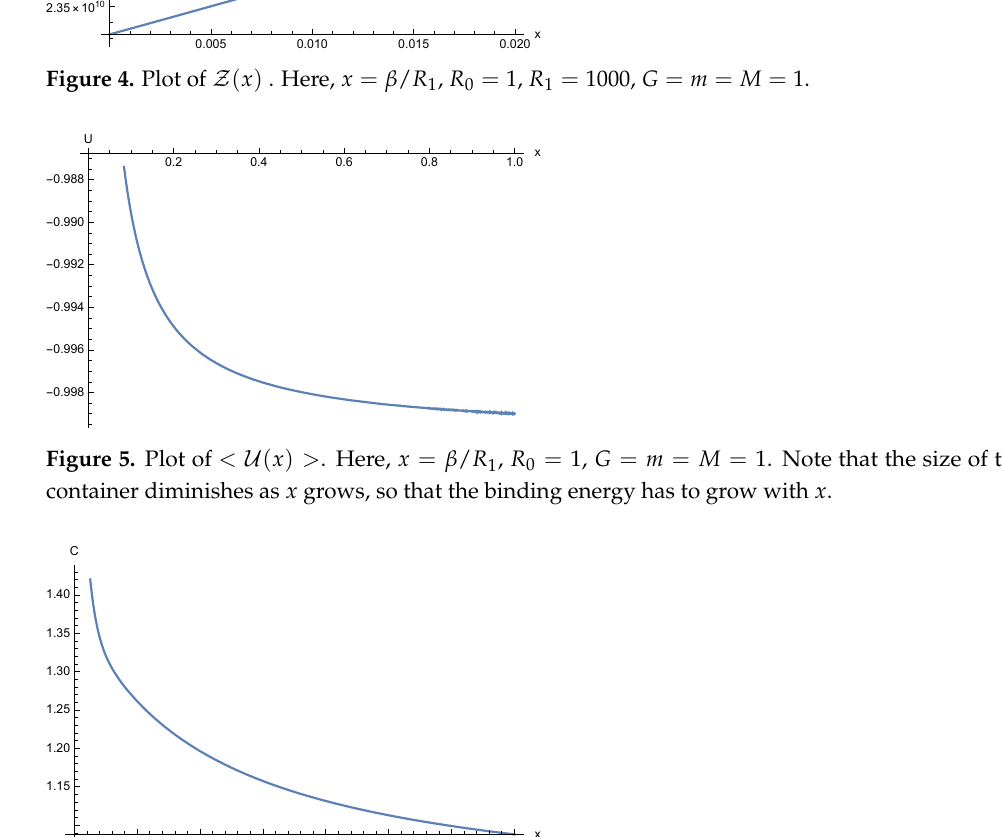
is positive. d β